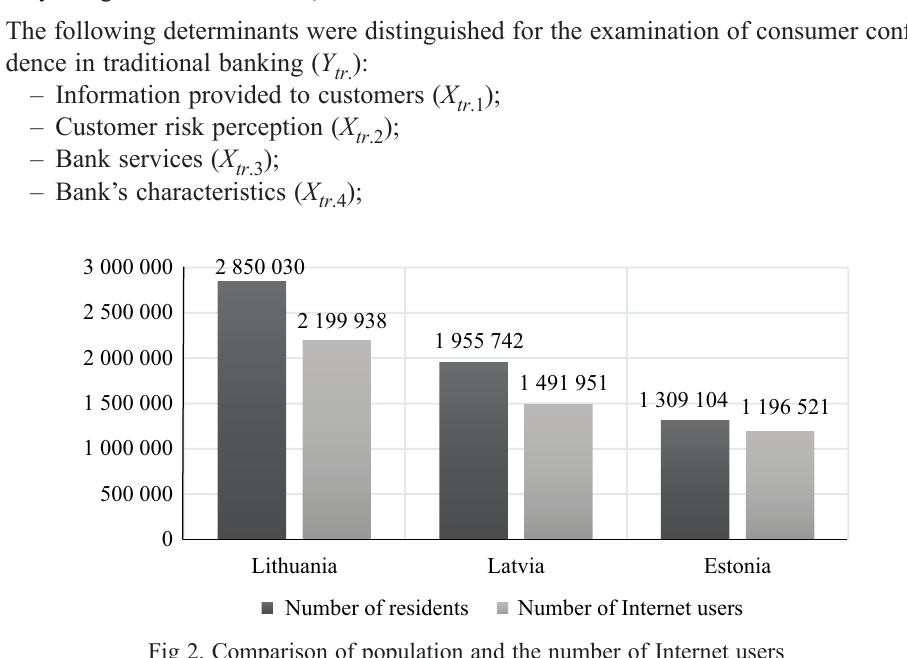
Fig 2. Comparison of population and the number of Internet